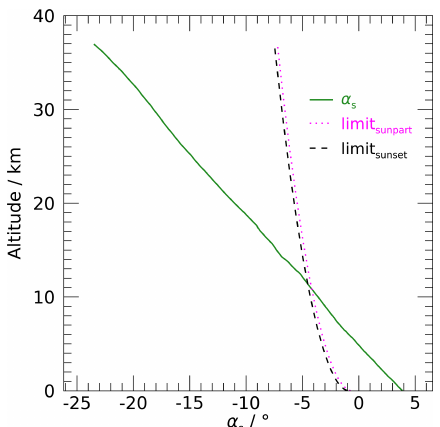
Figure 16. Example of solar-elevation angle α s , and assignment to daylight phases (day, night), for a sunset sounding in Singapore (9 May 2020, 12:00UTC). The radiosonde is launched ( h = 0km) shortly before sunset ( α s = 4 ◦ ). At about 11.5km the Sun is at first partially obscured when passing the horizon (limit sunpart ) and sets completely shortly afterwards (limit sunset ). Darkness is assumed for the remaining part of the ascent, i.e. twilight is considered insignif- icant for the radiation